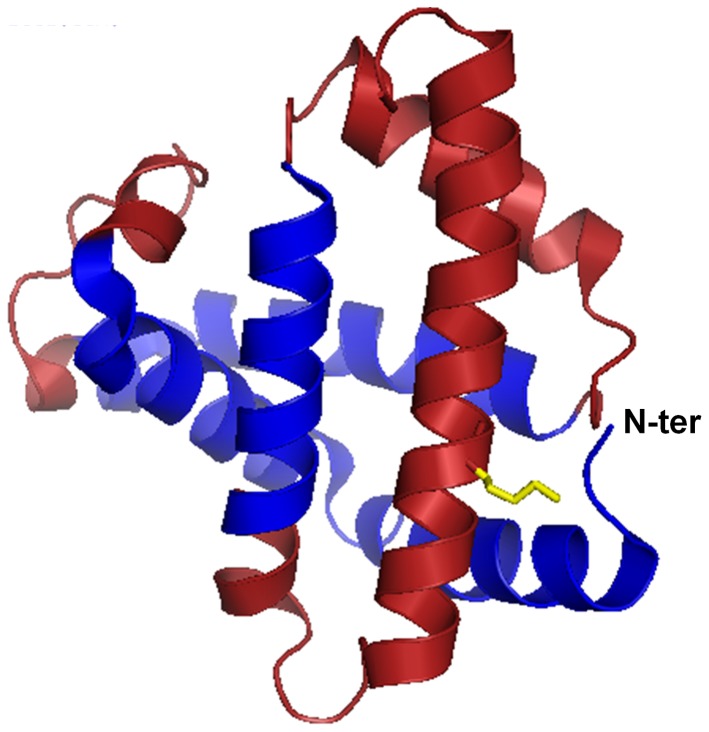
Proposed cross-linking in the glycated W7FW17F apomyoglobin.Structural representation of the W7FW14F apomyoglobin modeled on the wild-type protein X-ray structure (pdb 2JHO). Regions involved in the fibril core are shown in dark blue while solvent accessible regions are shown in red. Glycation is likely to promote a cross-linking between the N-terminus and the side chain of Lys133 (shown in yellow). The results are visualized using PyMol (The PyMOL Molecular Graphics System, Version 1.5.0.4 Schrodinger, LLC).